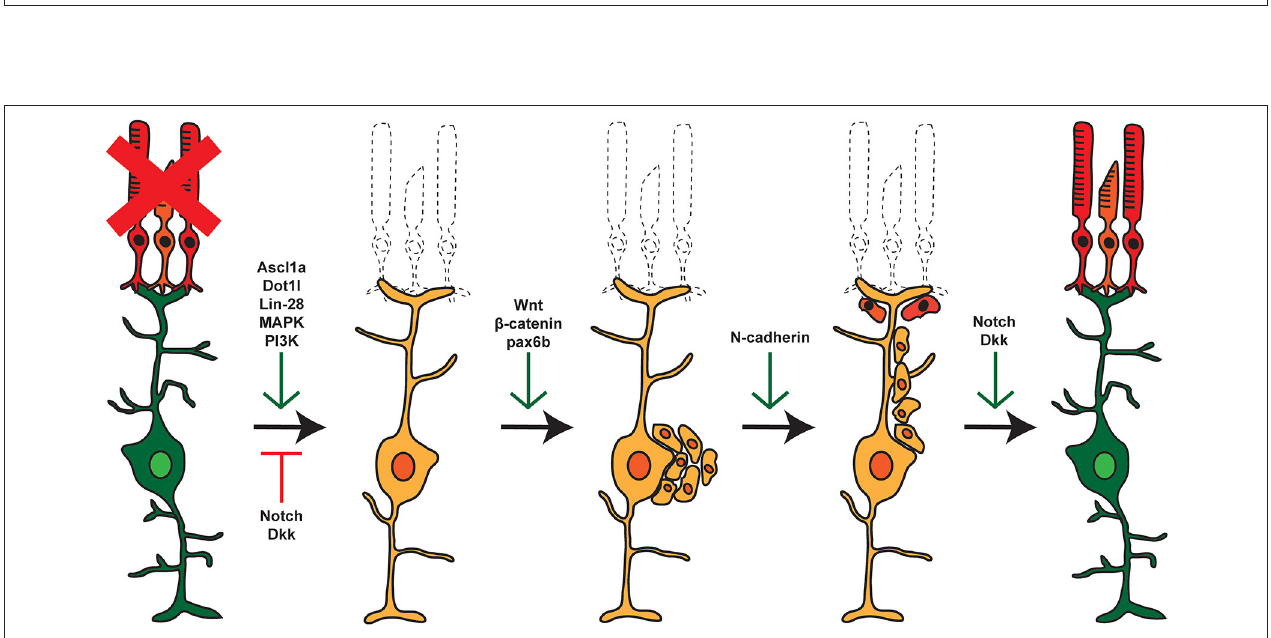
FIGURE 2 | Pathways and factors involved in retina regeneration. Following damage in the zebrafish retina, multiple pathways are activated controlling dedifferentiation of MG, re-entry into the cell cycle, asymmetric cell division, generation of proliferating RPCs, and eventual differentiation into replacement cell types. Green arrows represent factors that are active at the given step, whereas red arrows represent factors that are repressed or inactive at that time.